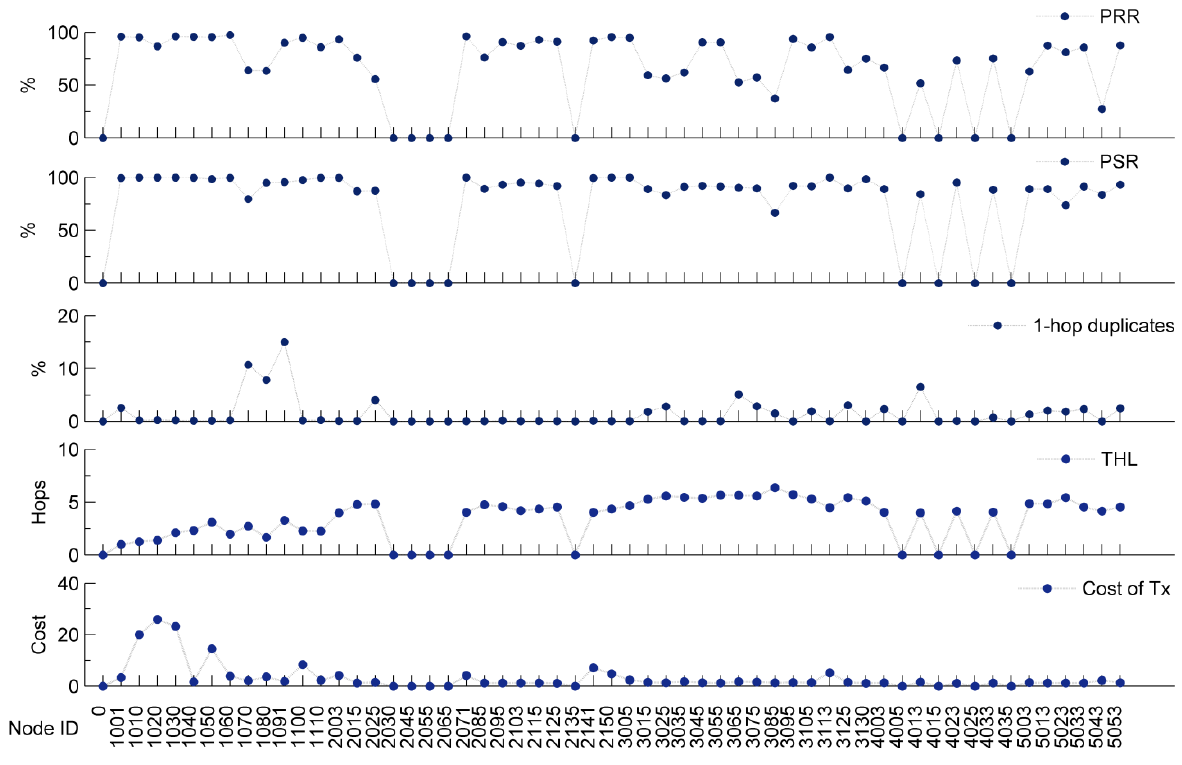
Figure 15. Node-level packet reception rate (PRR), packet success rate (PSR), percent single-hop duplicates, average time has lived (THL) and cost of transmissions during the CTP evaluation period.